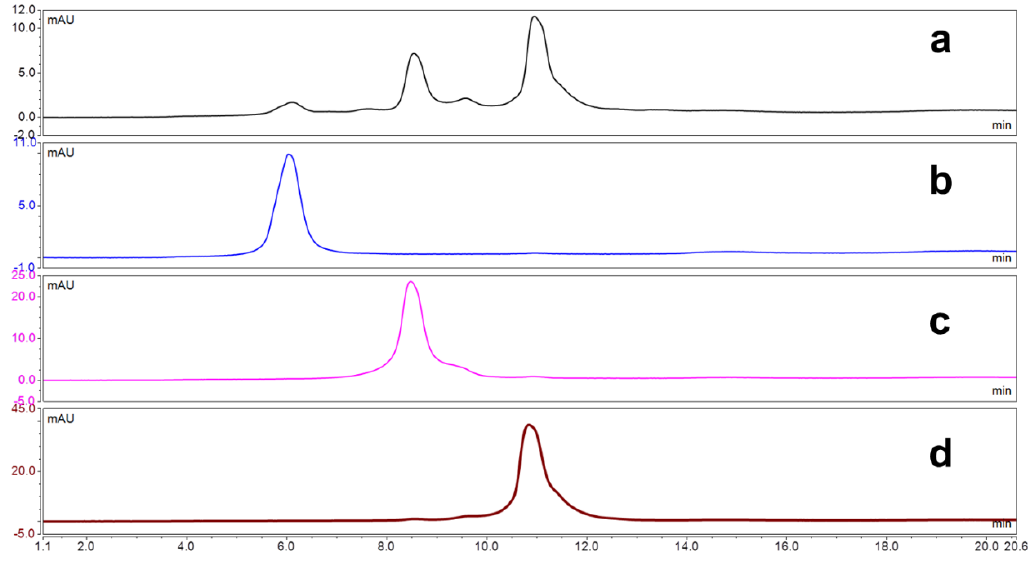
Figure 5. HIC analysis for DAR determination: ( a ) Unpurified ADC 4 (DAR = 1.6); ( b )